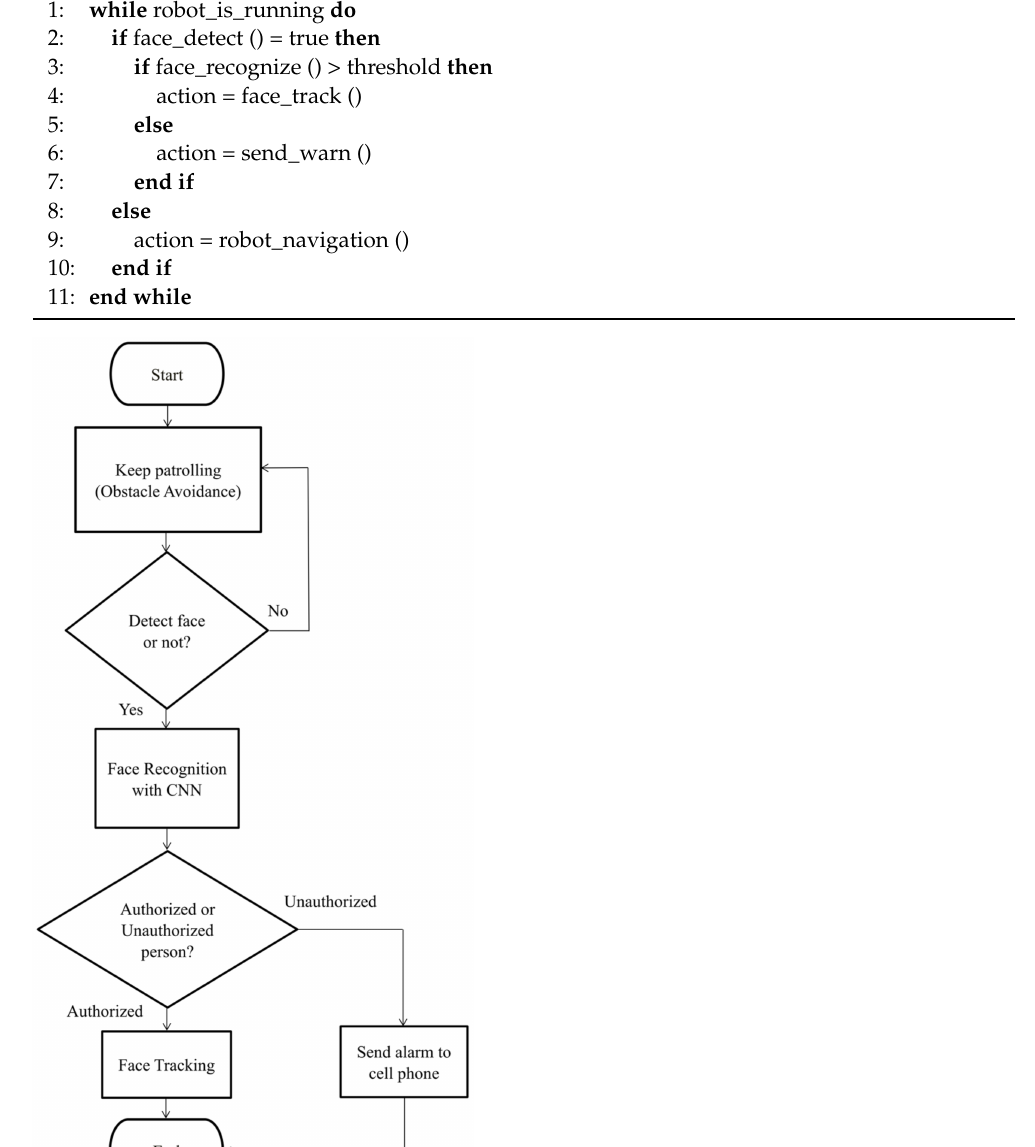
Algorithm 6 Program procedure of proposed security robot.